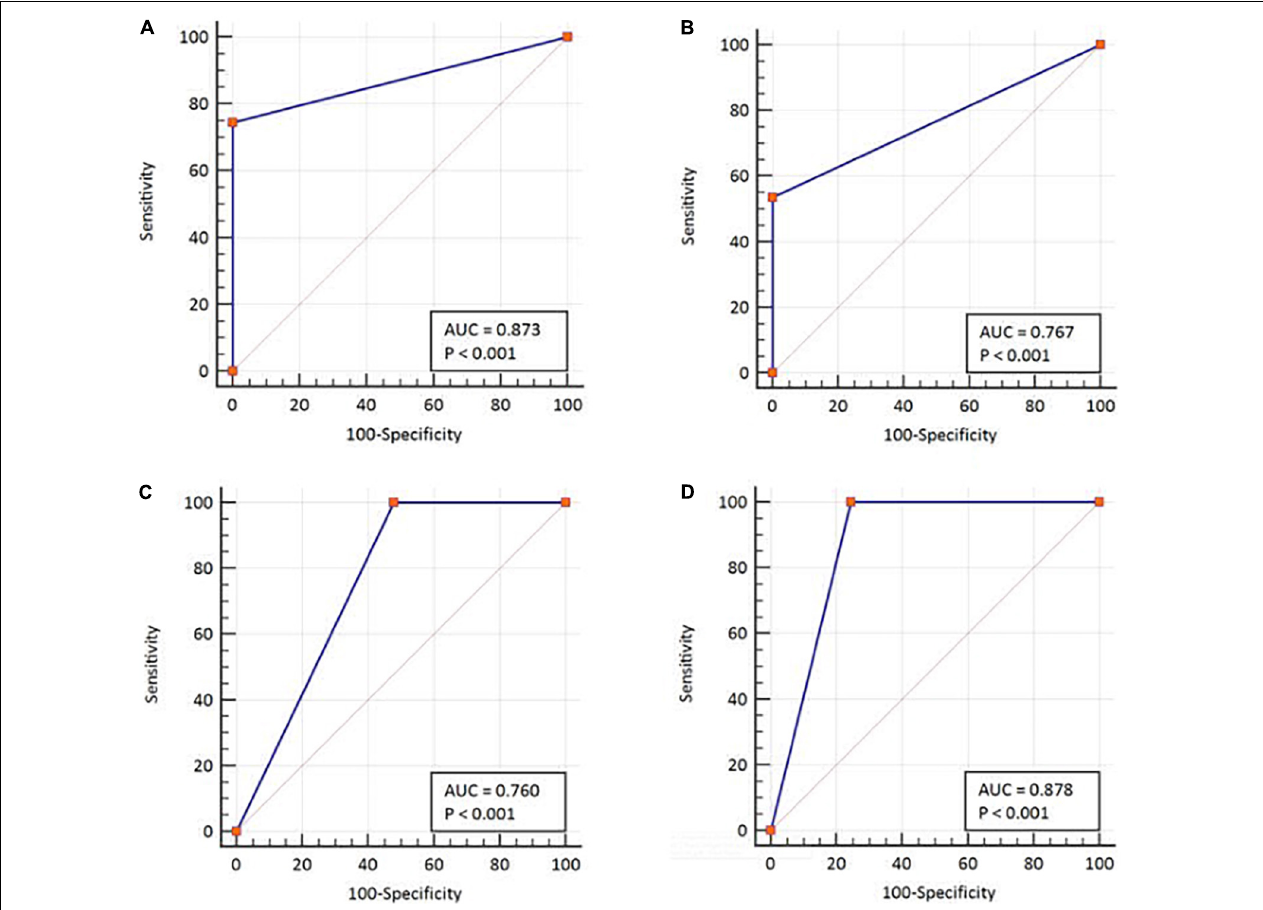
FIGURE 3 | ROC-curve analysis with respect to the two diagnostic classification variables. By using rRT-PCR as a reference, (A) Ag rapid FIA and (B) Ag Gold. Using cell culture test as a reference, (C) Ag rapid FIA and (D) Ag Gold. ROC, receiver operating characteristic; AUC, area under the ROC curve. The AUCs were characterized as follows: 0.5 as no discrimination; 0.7–0.8 as excellent; and > 0.9 was considered outstanding.